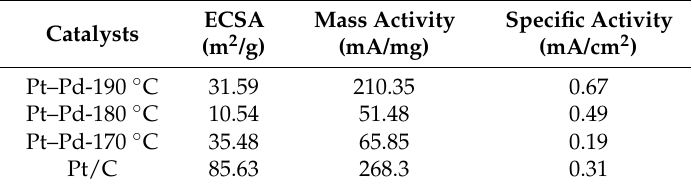
Figure 5. Cyclic voltammetry (CV) curves of Pt–Pd nanoparticles prepared at different temperatures and commercial Pt/C: ( a ) in 0.5 M H 2 SO 4 solution; ( b ) in 1.0 M methanol + 0.5 M H 2 SO 4 solution, mass activities; and ( c ) in 1.0 M methanol + 0.5 M H 2 SO 4 solution, specific activities. The scan rate was 50 mV/s. Table 1. The catalytic activities of Pt–Pd nanoparticles at different temperatures and commercial Pt/C for methanol oxidation